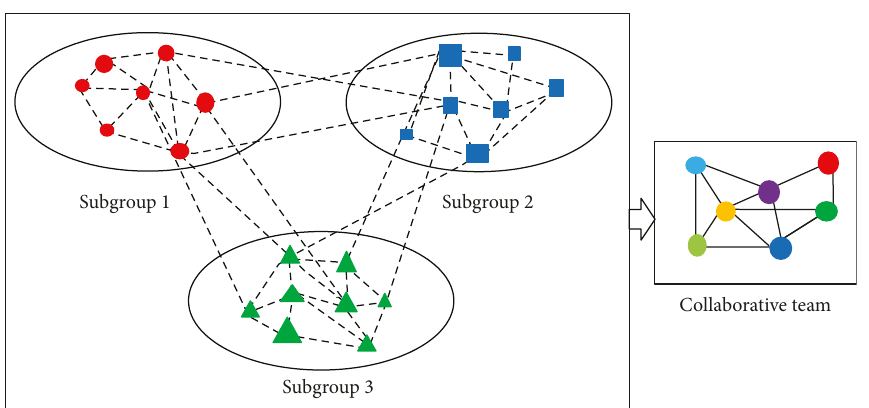
Figure 8: Formation of team member selection